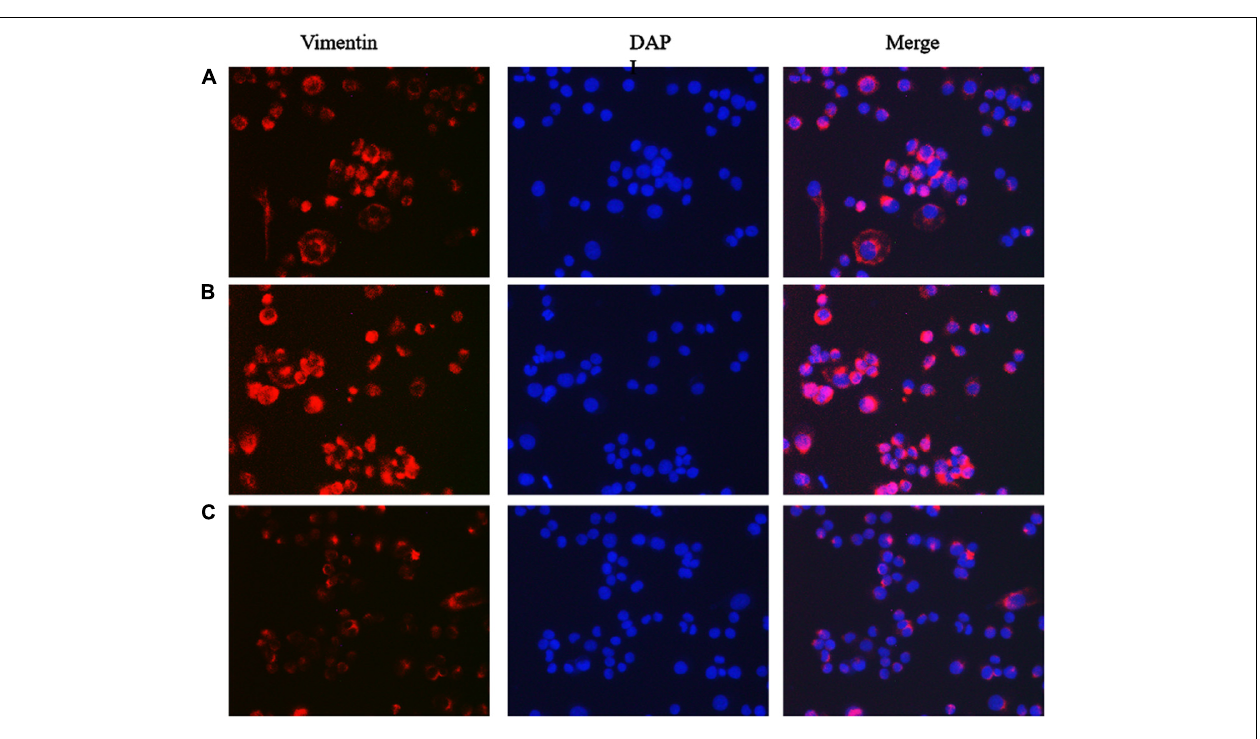
Frontiers in Cell and Developmental Biology |